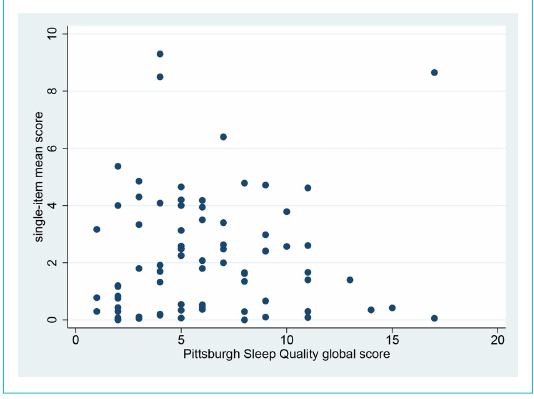
Figure 2: Relationship between the PSQI global score and the sin- gle-item mean score.